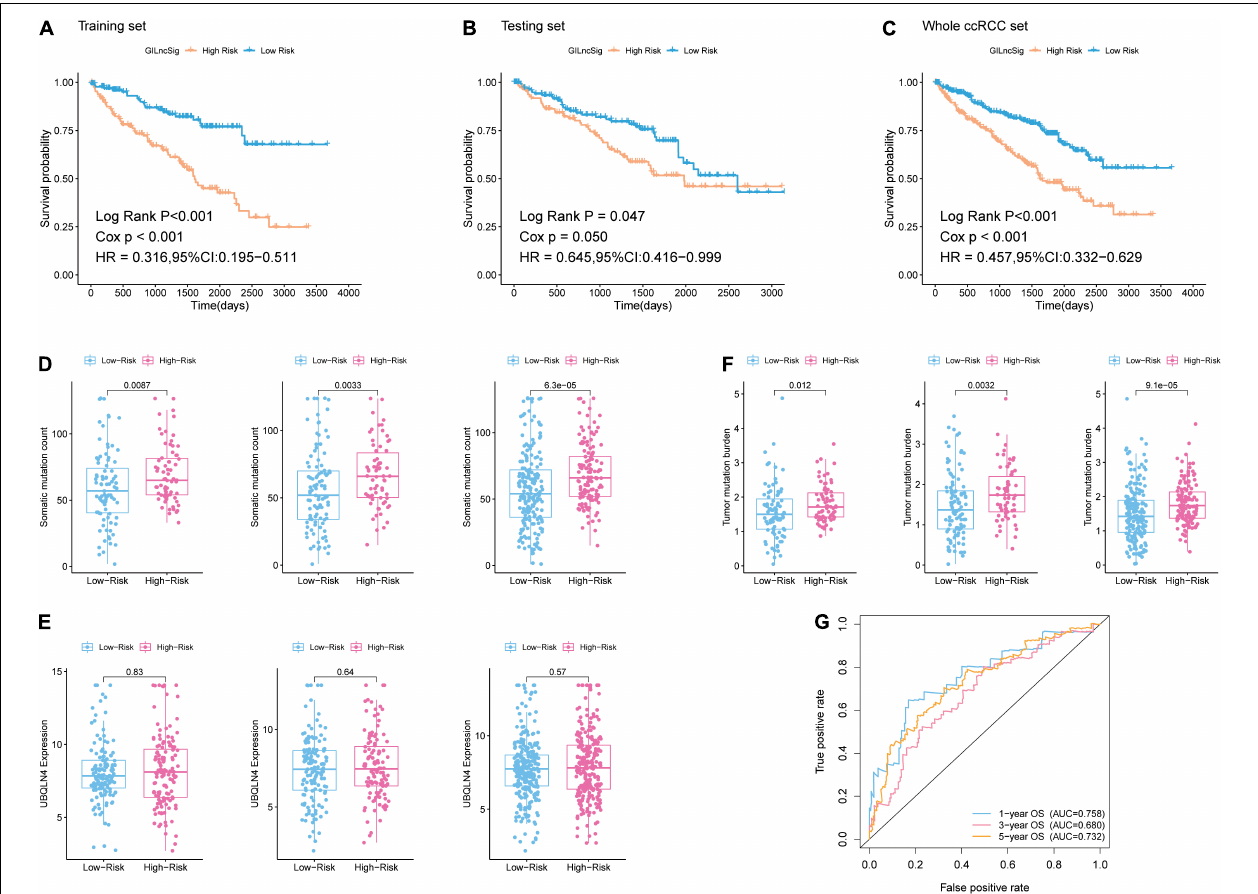
FIGURE 3 | Identification of the predictive efficacy of the model. (A) Kaplan–Meier curves of overall survival of patients with low or high risk predicted by the GILncSig in the training set. (B) Kaplan–Meier curves of overall survival of patients with low or high risk predicted by the GILncSig in the testing set. (C) Kaplan–Meier curves of overall survival of patients with low or high risk predicted by the GILncSig in the whole ccRCC set. (D) Boxplots of somatic mutation count in the High-Risk group and Low-Risk group in three sample sets. Somatic cumulative mutations in the High-Risk group were significantly higher than those in the GS-like group. (E) Boxplots of UBQLN4 expression level in the High-Risk group and Low-Risk group in three sample sets. The expression level of UBQLN4 in the High-Risk group showed no difference compared with that in the Low-Risk group. (F) Boxplots of tumor mutation burden in the High-Risk group and Low-Risk group in three sample sets. Tumor mutation burden in the High-Risk group was significantly higher than that in the Low-Risk group. (G) Time-dependent ROC curve analysis of the GILncSig at 1, 3, and 5 years.